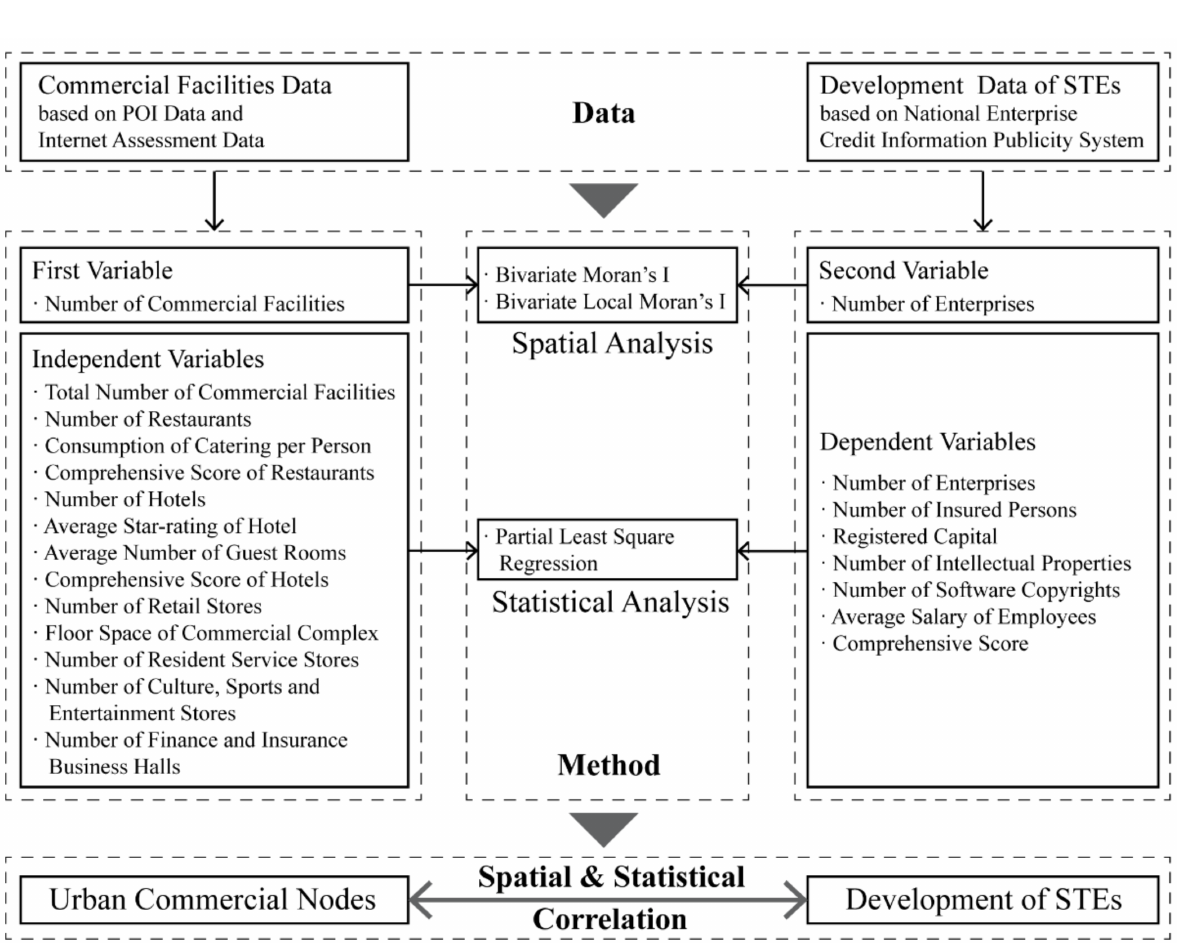
Figure 7. Flowchart of study